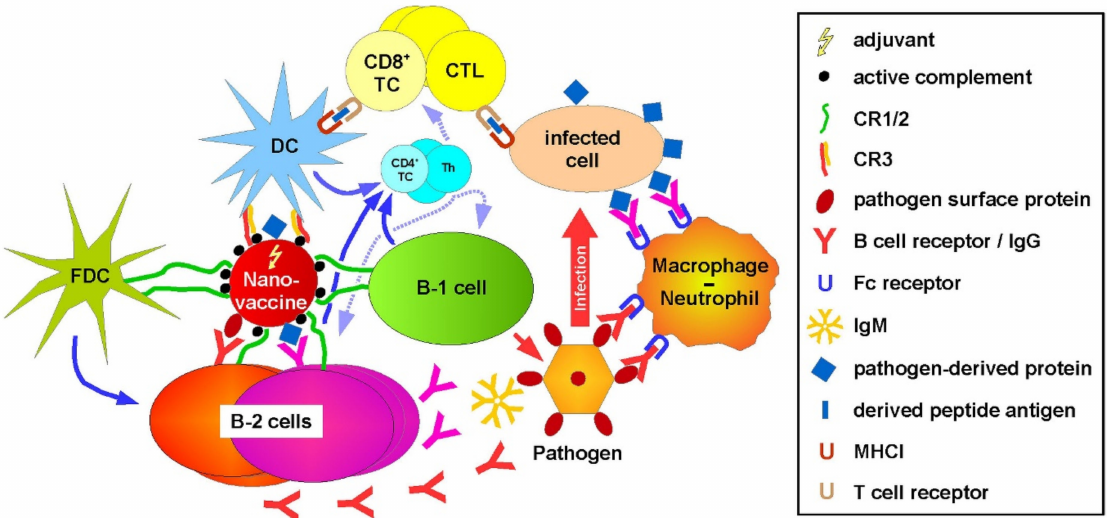
Figure 8. Nano-vaccines coated with active complement may concomitantly induce cellular and humoral immune responses. A nano-vaccine decorated with active complement may address B cells (B-1, B-2) and follicular dendritic cells (FDC) via CR1/2 and (conventional) DC via CR3. In the case of B-2 cells, antigen-specific internalization may be achieved by decoration with a pathogen-specific protein binding the B cell receptor. Codelivery of an adjuvant will result in the production of antigen-specific antibodies (B-2), which opsonize either the pathogen or the infected cells. Exposed Fc parts can trigger the classical complement pathway and directly bind Fc receptors. Antibody and/or complement-opsonized pathogens and infected cells are phagocytosed by myeloid cell types. Uptake of the nano-vaccine by B-1 cells may result in enhanced production of IgM and phagocytosis of pathogens via yet unknown receptors. Stimulated DC activates antigen-specific CD8 + T cells, yielding cytotoxic T lymphocytes (CTL). CTL, in turn, kills infected cells that present the corresponding antigen. Full activation of CD8 + T cells and B-2 cells requires help by activated CD4 + T cells, called T helper cells (Th). These are stimulated by activated antigen-presenting cells, namely DC and B cells (B-1, B-2). FDC facilitates sustained B cell